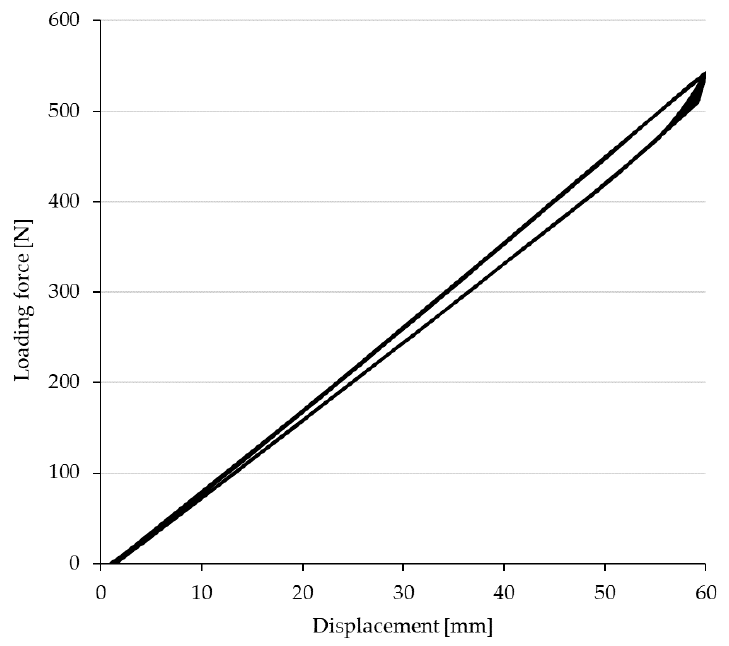
Figure 9. Example of part of one cycle of low cycle fatigue of a hybrid ski design.